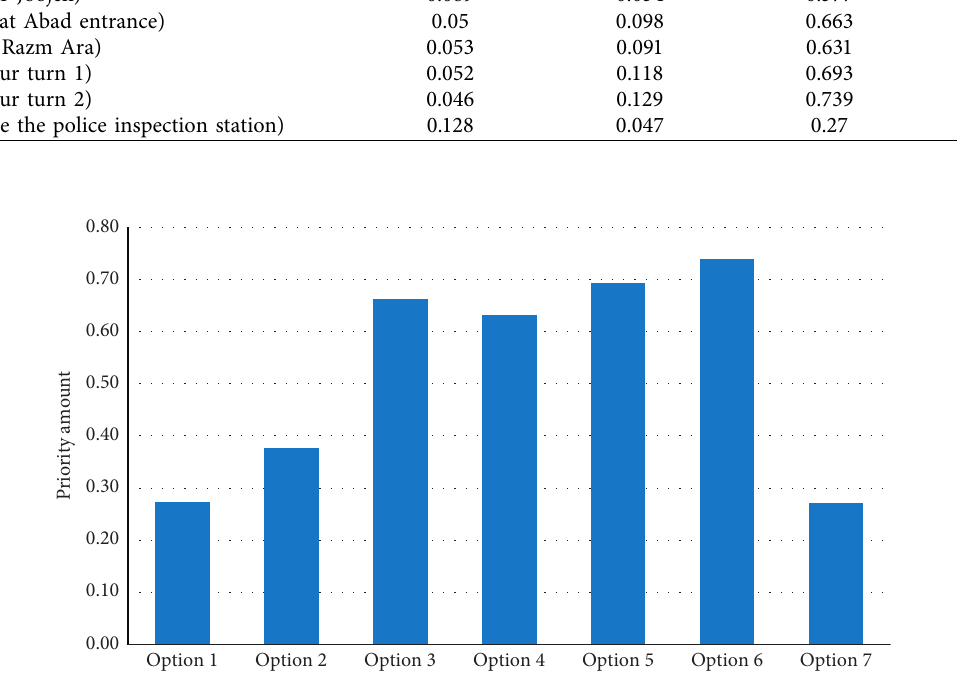
Figure 10: Final priority of